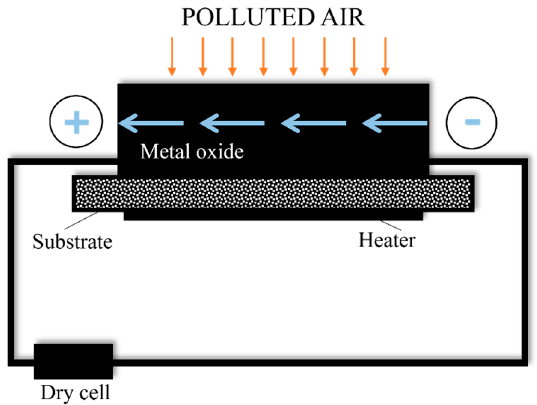
Figure 3. Diagram of MOS-type sensor operation. Based on